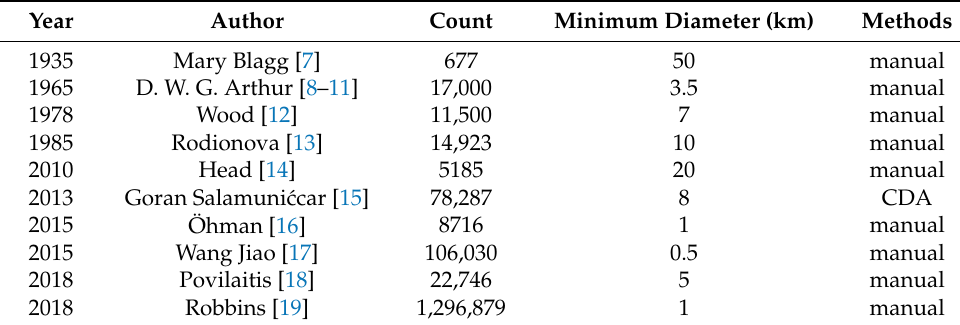
Table 1. Main Lunar Crater